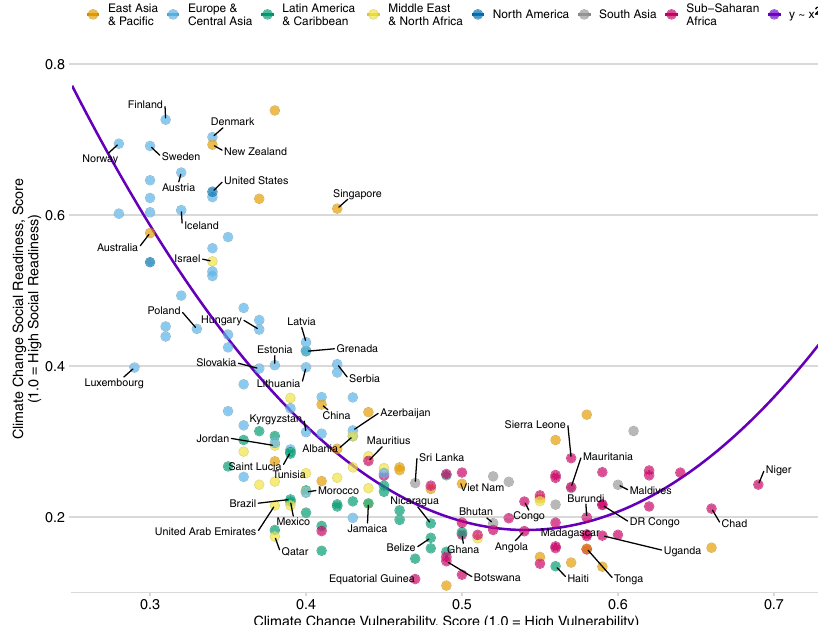
Fig. 9 Relationship between climate change social readiness and climate change vulnerability. This plot captures regional convergence (i.e., East Asia & Paci fi c, Europe & Central Asia, Latin America & Caribbean, Middle East & North Africa, North America, South Asia, and Sub-Saharan Africa) of sampled economies based on average annual